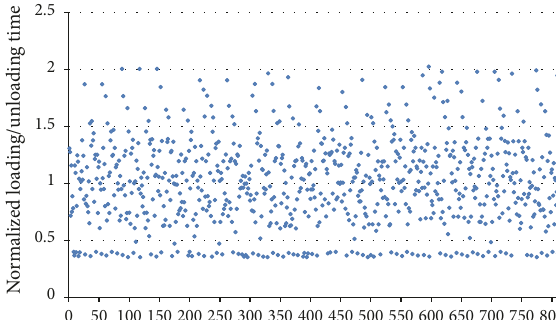
Figure 20: Simulated train loading/unloading time distribution.